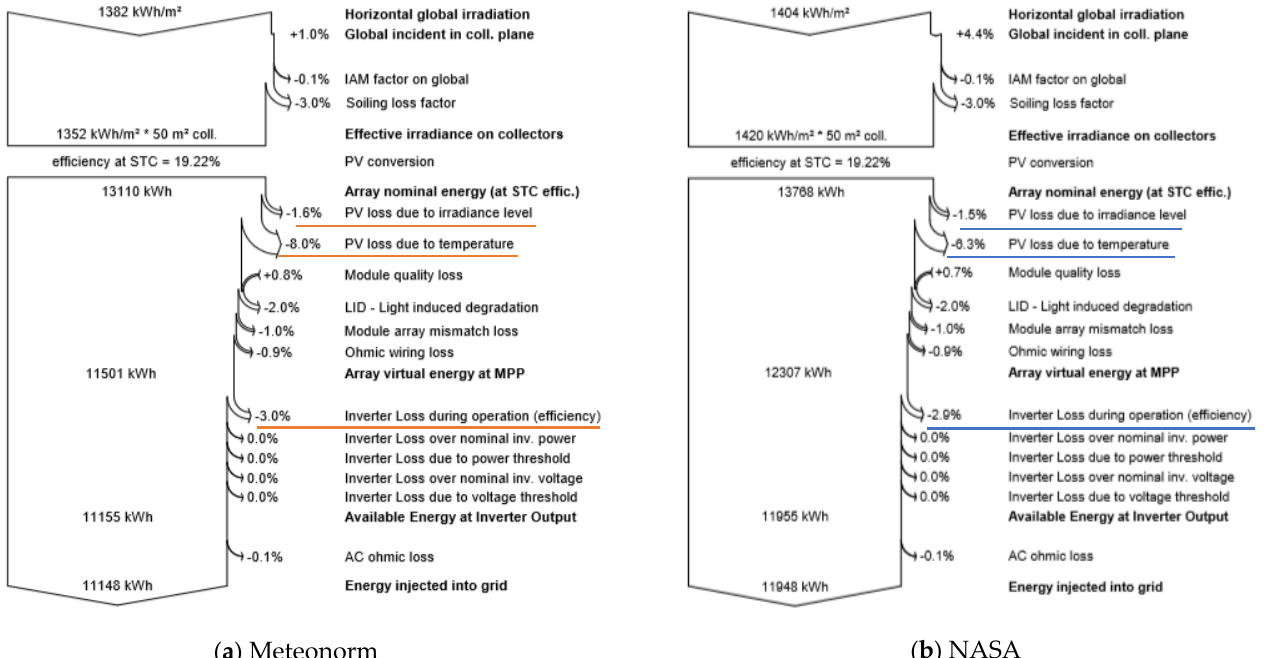
Figure 10. Power loss diagram according to Meteonorm ( a ) and NASA ( b ) data.